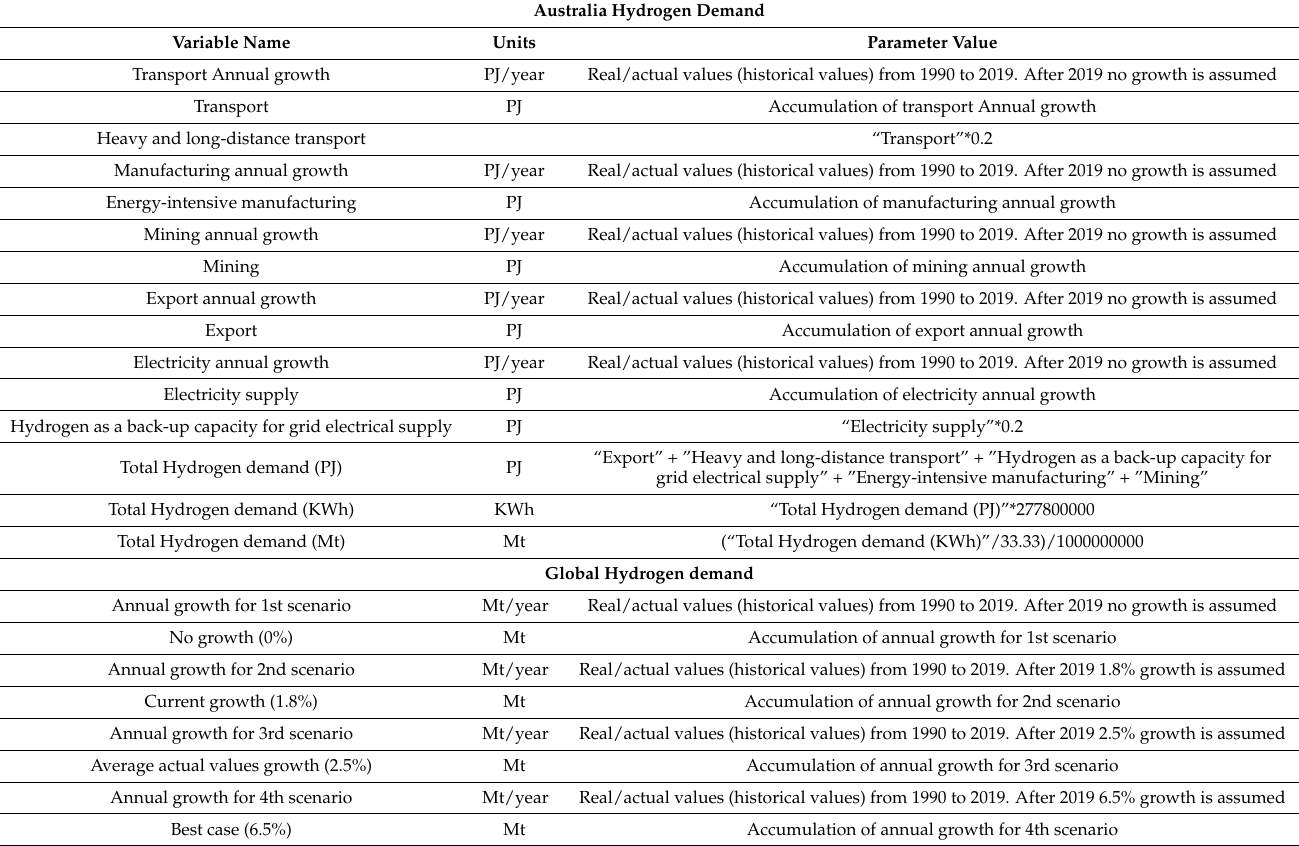
Table A1. Parameters used in the simulation model. The model produces behaviours over time graphs from 1990 to 2050. The software used is Silico